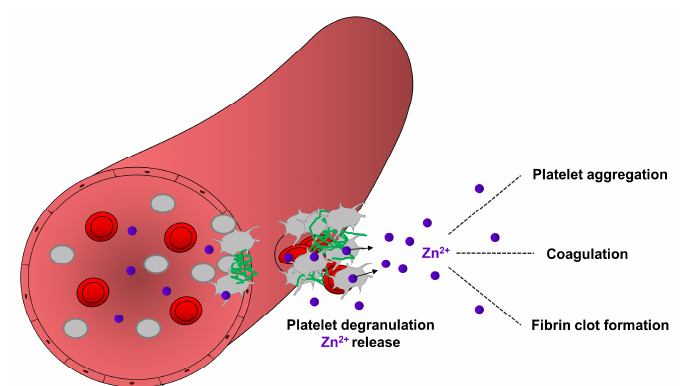
Figure 2. Contribution of platelet-resident Zn 2+ in the regulation of hemostasis. During hemostasis, a process which stops bleeding, platelets accumulate in the site of injury and became activated. Activated platelets release Zn 2+ from their granules, which may enhance the aggregation of circulating platelets, modulate the activity of proteins of coagulation and fibrinolytic pathways. Zn 2+ can bind to fibrinogen and fibrin and modulate the ultrastructure and mechanical strength of fibrin, thereby supporting fibrin clot formation during hemostasis.